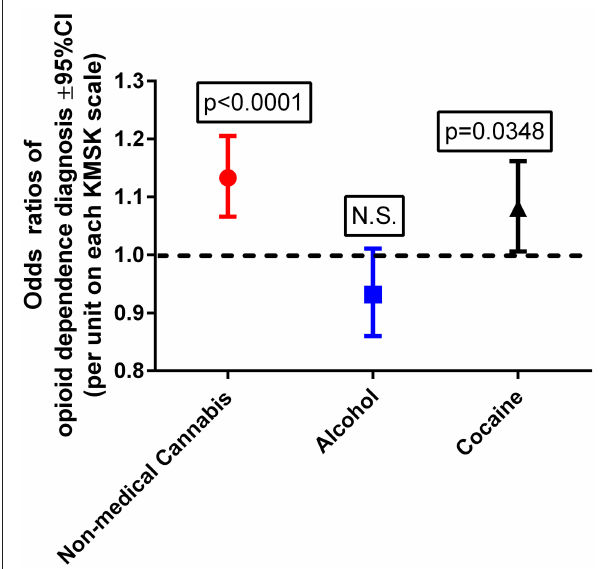
FIGURE 2 | Odds ratios of opioid dependence diagnosis, with cannabis, alcohol, and cocaine KMSK scores as dimensional predictors. The ordinate is the odds ratio ( ± 95%CL), calculated for a 1-unit score increment in each of the KMSK scales (see Table 2 ). The multiple logistic regression was calculated after the propensity score matching procedure (two groups, n = 89 each; see Table 5